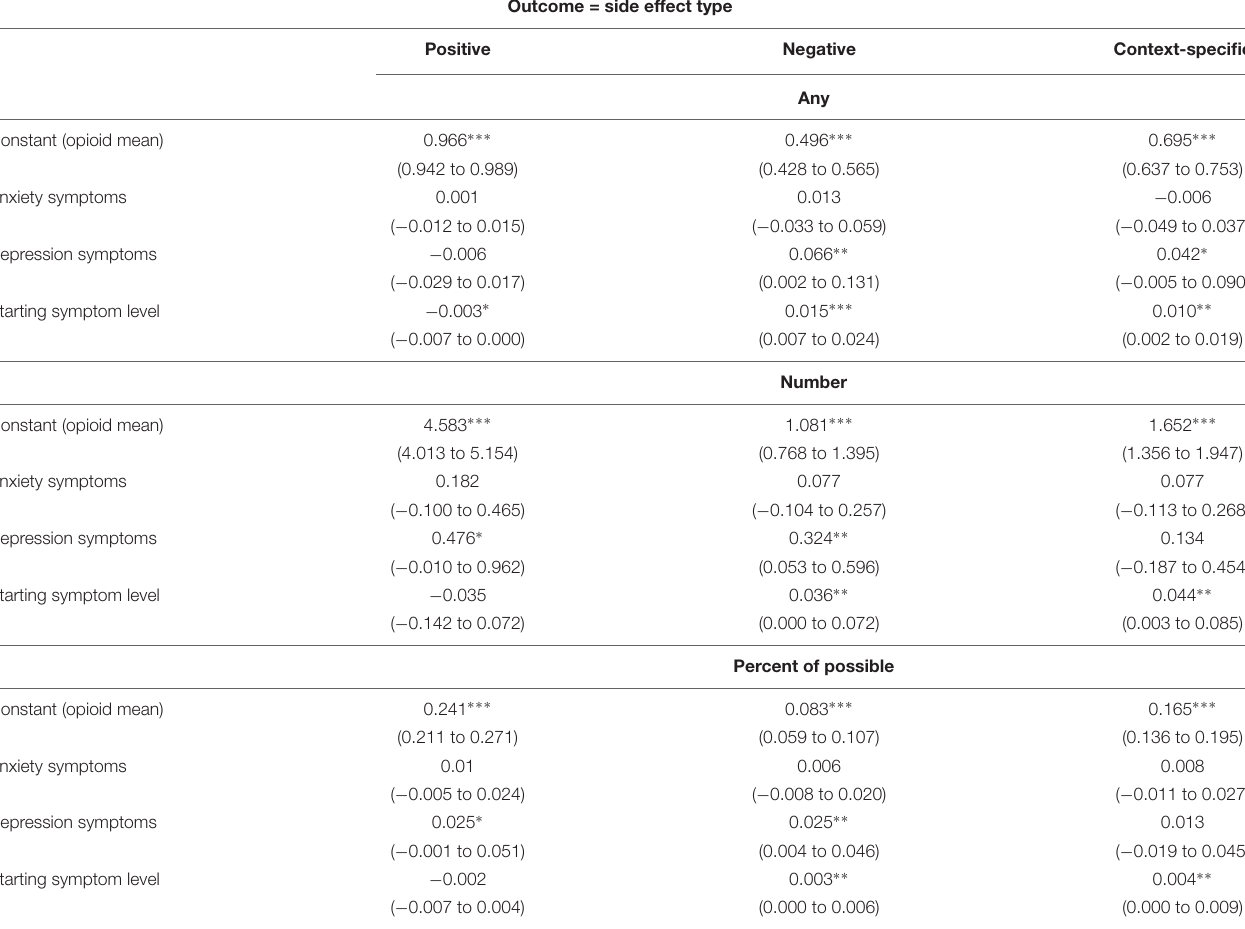
TABLE 3 | Differences in side effect profiles across symptom